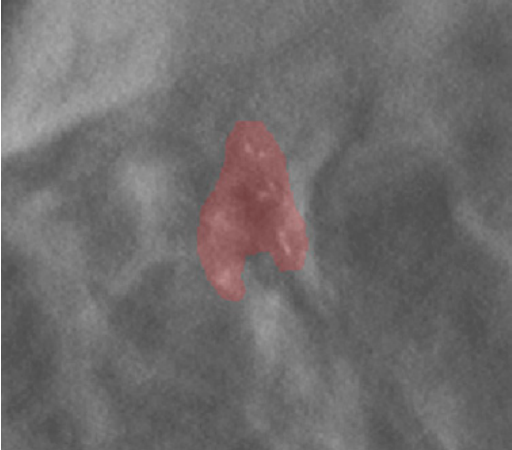
Figure 1. An example of ROI segmentation on a centering tomosynthesis image acquired in the biopsy session.